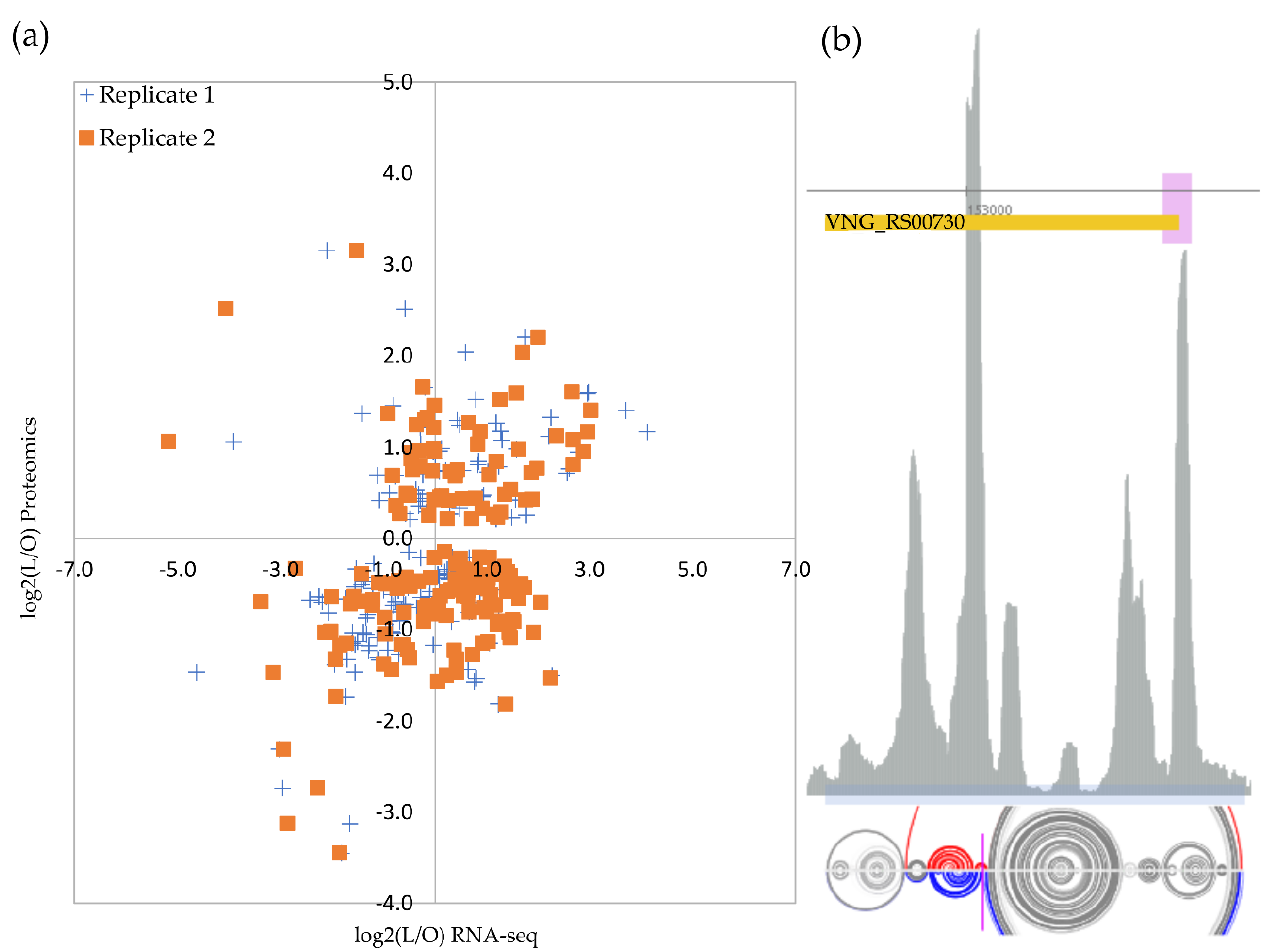
Figure 3. Transcriptome and proteome comparison. ( a ) Optimum growth condition is 4.3 M NaCl (O) and low salt is 2.6 M NaCl (L). Proteome data from Leuko et al. (2009) [9]. The relative number of genes in every four quadrants is shown. ( b ) Example of the putative post-transcriptionally regulated gene, 50S ribosomal protein L15e ( rpl15e ), and its Ribo-seq ribosome footprint profile (gray sequenced reads counting peaks in arbitrary scale). Ribo-seq data from Lorenzetti et al. (2022) [30]. The orange box is the annotated CDS with 5’-3’ direction shown from right to left. The pink box indicates the SmAP1 RNA chaperone binding site. Magenta marker indicates transcription processing site. The light blue box indicates the region used for RNA structure prediction with arch representations for the two thermodynamically stable predictions in the ensemble below (bases connected by an arch are predicted to be pairing, gray arches are similar pairing predictions in both structure models, and colored are different). See text for details.